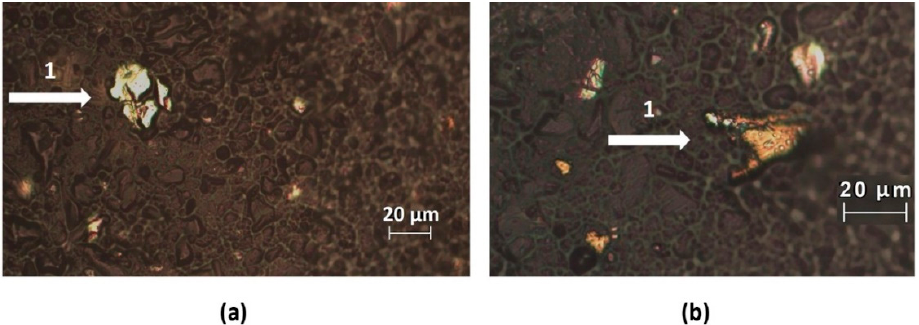
Figure 5. Reflected optical microscope images of the pretreatment products at a magnification of ×50 ( a , b ). Chalcopyrite identified in ( a , b ) as (1).